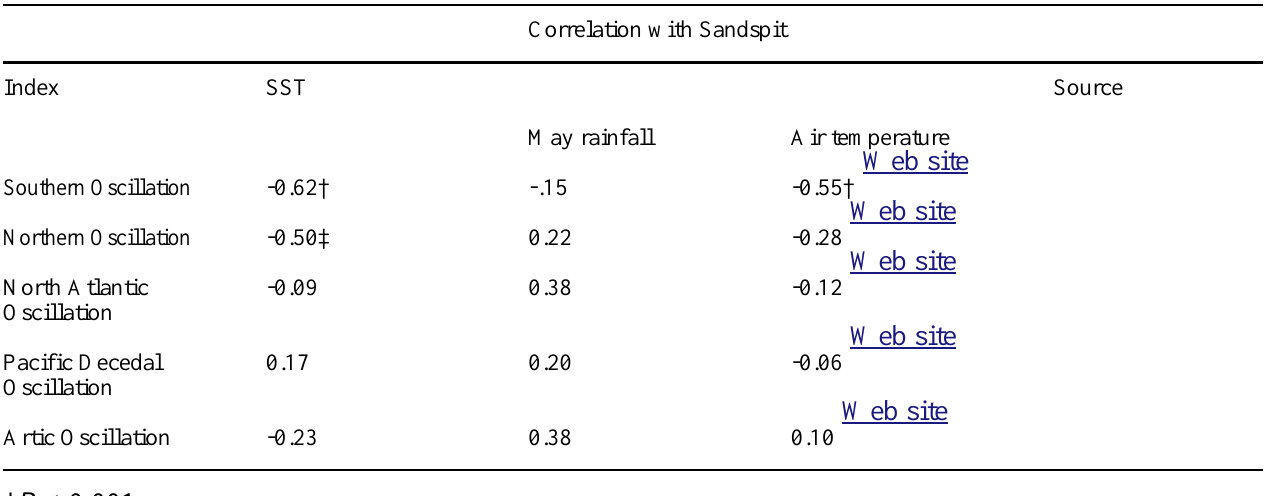
Table 1 . Pearson correlations coefficients among atmospheric indices and air and sea surface temperatures (SST) and precipitation in Haida